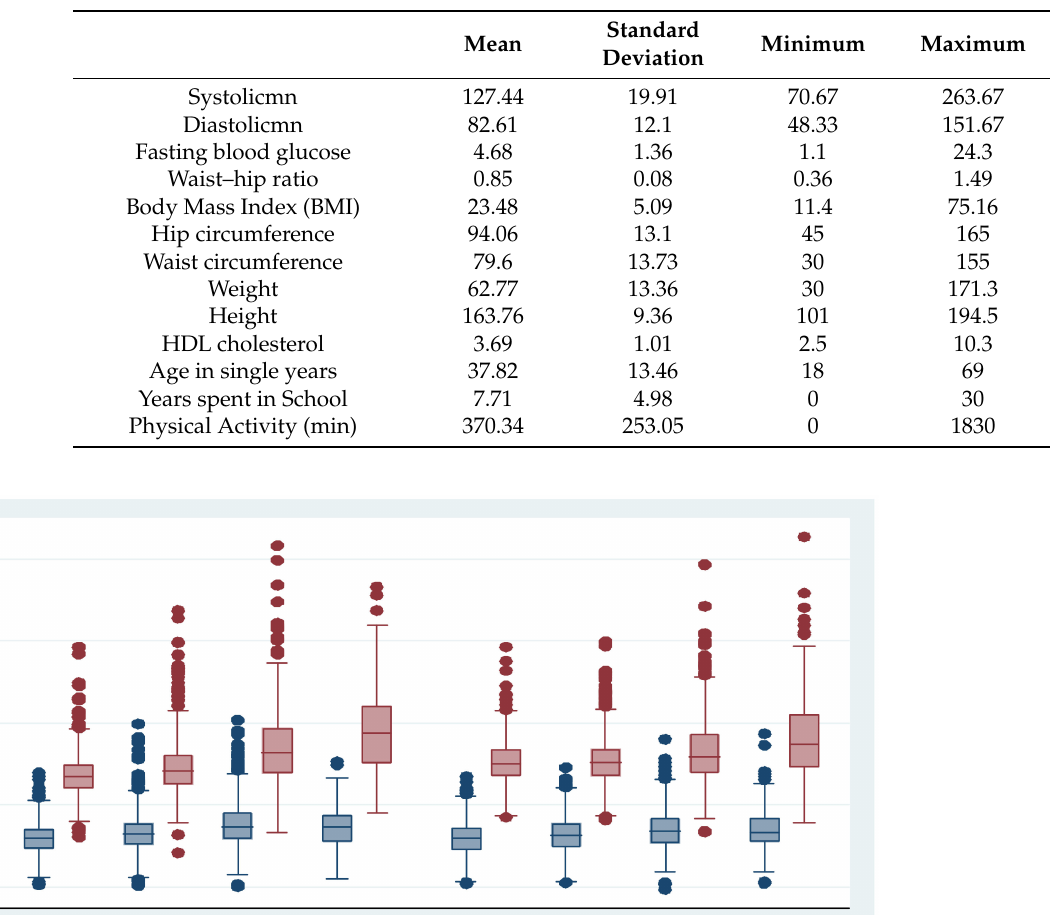
Table 2. Descriptive statistics of physical measures and continuous variables.